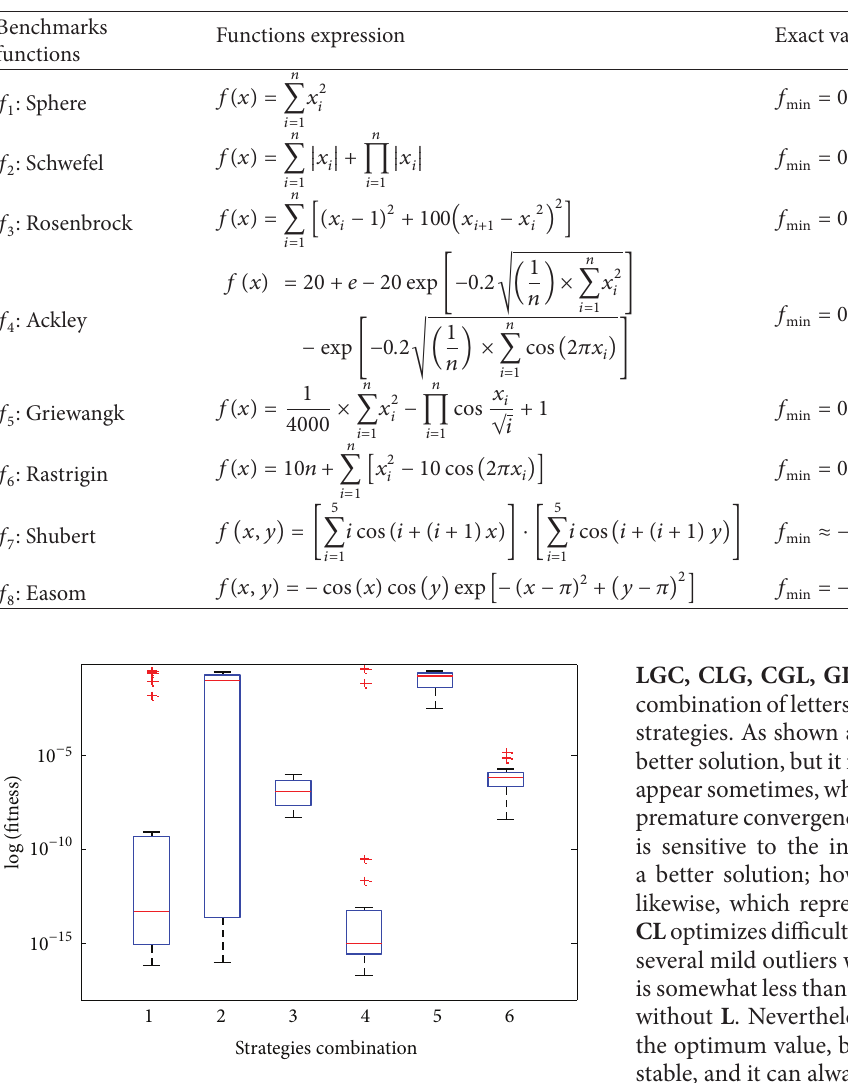
Figure 6: Box-and-whisker after 20 runs independently about different strategies